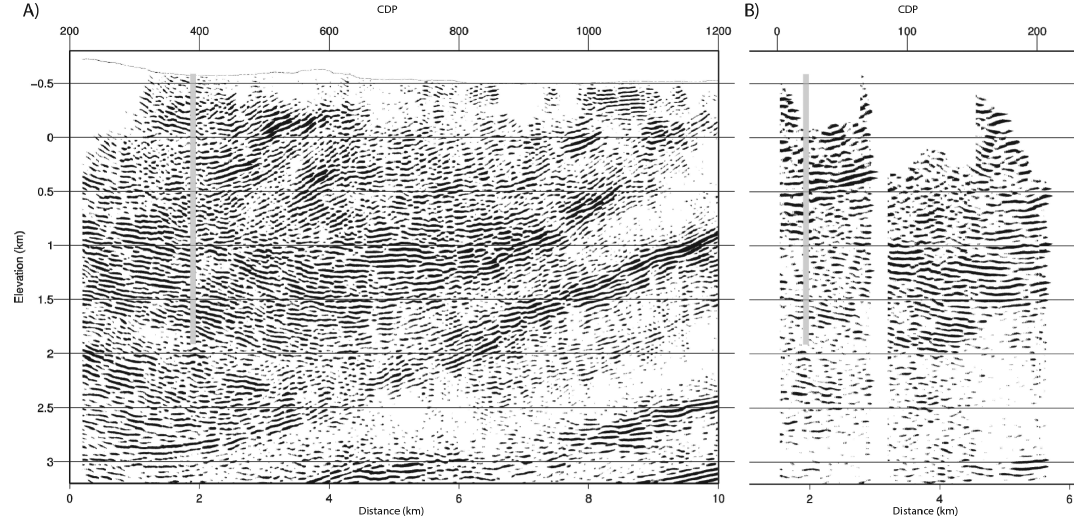
Figure 10. Seismic data from the pre-drilling seismic survey (a) as in Hedin et al. (2012) (b) reprocessed with a 3-D geometry over the crooked acquisition line. The grey vertical line indicates the location of the COSC-1 drill